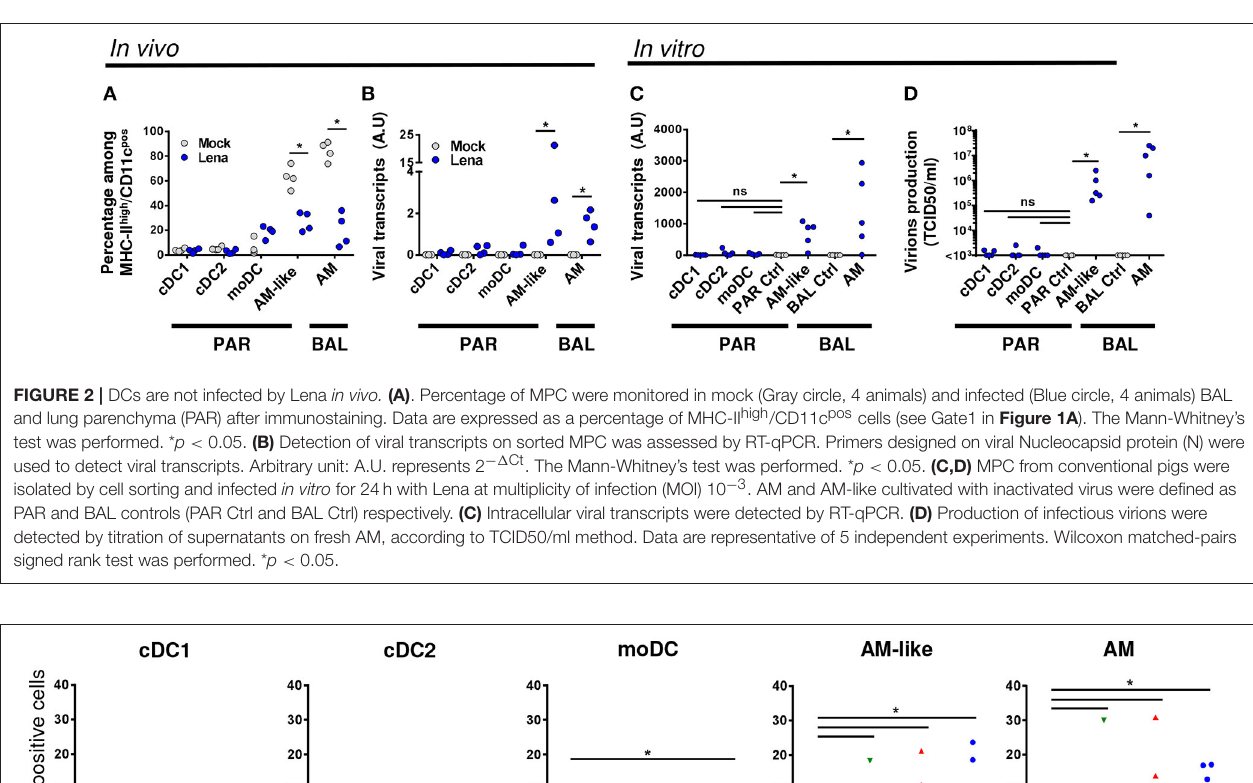
Frontiers in Immunology |